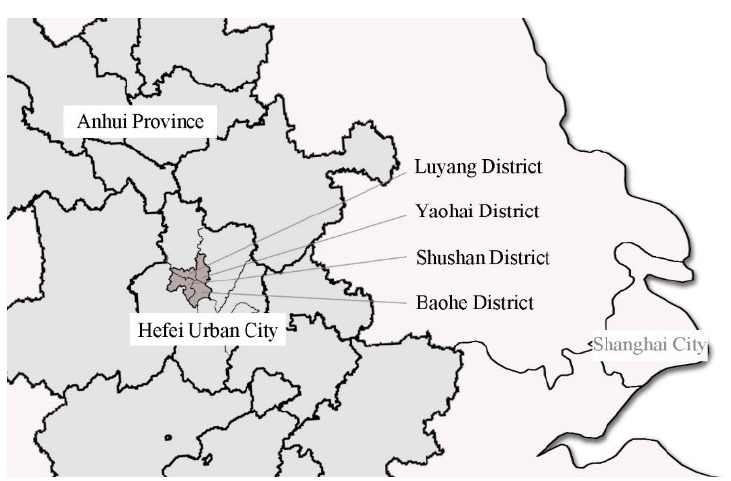
Figure 1. Location of Hefei urban city.